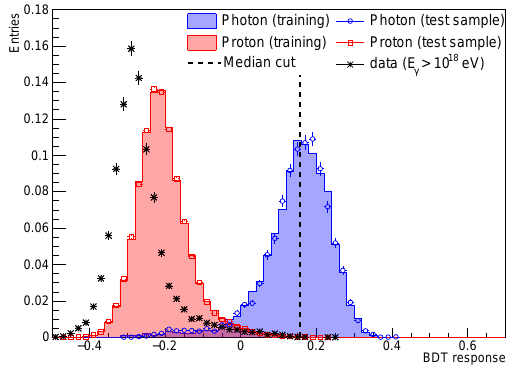
Figure 7. Distribution of the Boosted-Decision-Tree response for the data sample (asterisks), photon simulations (blue-shaded histogram and circles), and proton background sample (red- shaded histogram and squares). The photon candidate cut at the median of the photon distribution is indicated by the dashed